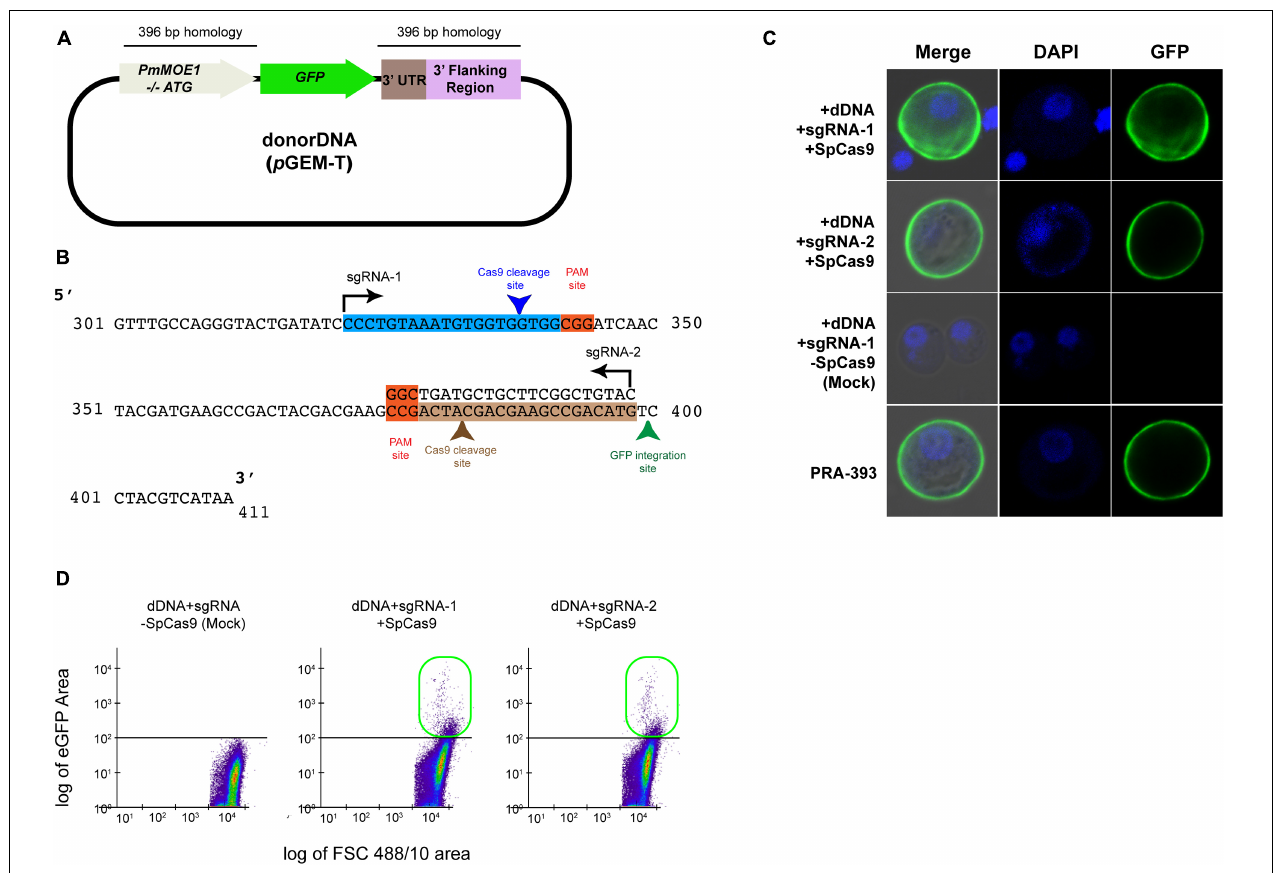
FIGURE 3 | SpCas9-RNP and sgRNA-mediated GFP knock-in in P. marinus trophozoites. (A) Schematic representation of dDNA with 396 bp homology on the 5 (cid:48) and 3 (cid:48) of the GFP coding sequence. (B) Schematic representation of showing the guide RNA target sites on PmMOE1 coding sequence sgRNA-1 targets the top strand indicated by the arrow direction; sgRNA-2 targets the bottom strand indicated by the arrow direction. (C) Confocal microscopy panel showing successful GFP expression in cells transfected with sgRNA-1/SpCas9 and sgRNA-2/SpCas9, showing localization pattern similar to the PRA-393 MOE-GFP mutant strain. (D) The scattered plot from FCM showing no GFP expression in mock (dDNA+sgRNA alone) control and 0.2% GFP-positive cells knocked in using sgRNA-1, and 0.35% in case of sgRNA-2 indicated in the green